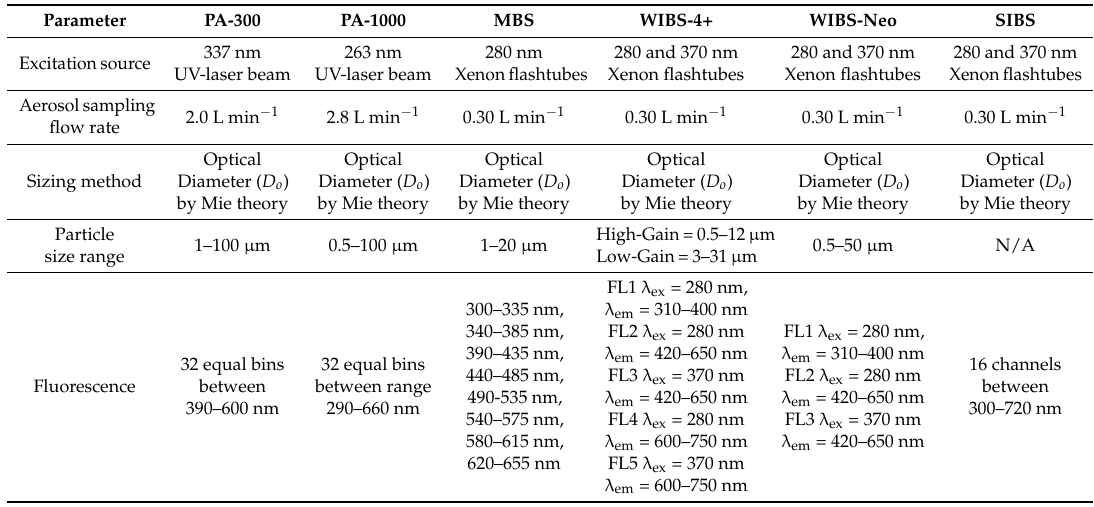
Table 6. Comparison between reported instrumental parameters of future